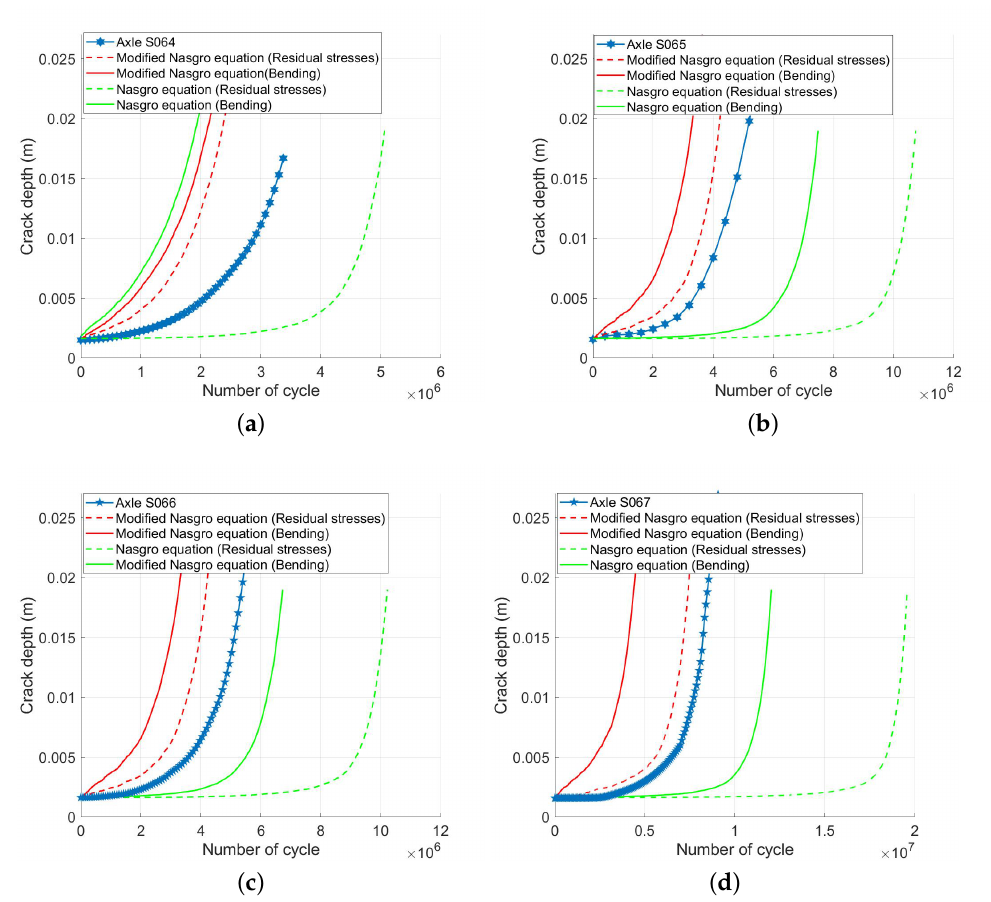
Figure 9. Residual lifetime predictions and comparison with the full-scale axle test results: ( a ) Axle S064, ( b ) Axle S065, ( c ) Axle S066, and ( d ) Axle S067.